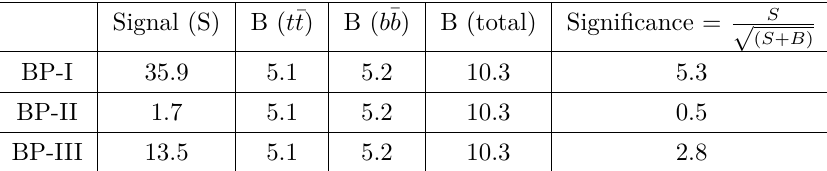
√ s = 13 TeV and L = 137 fb − 1